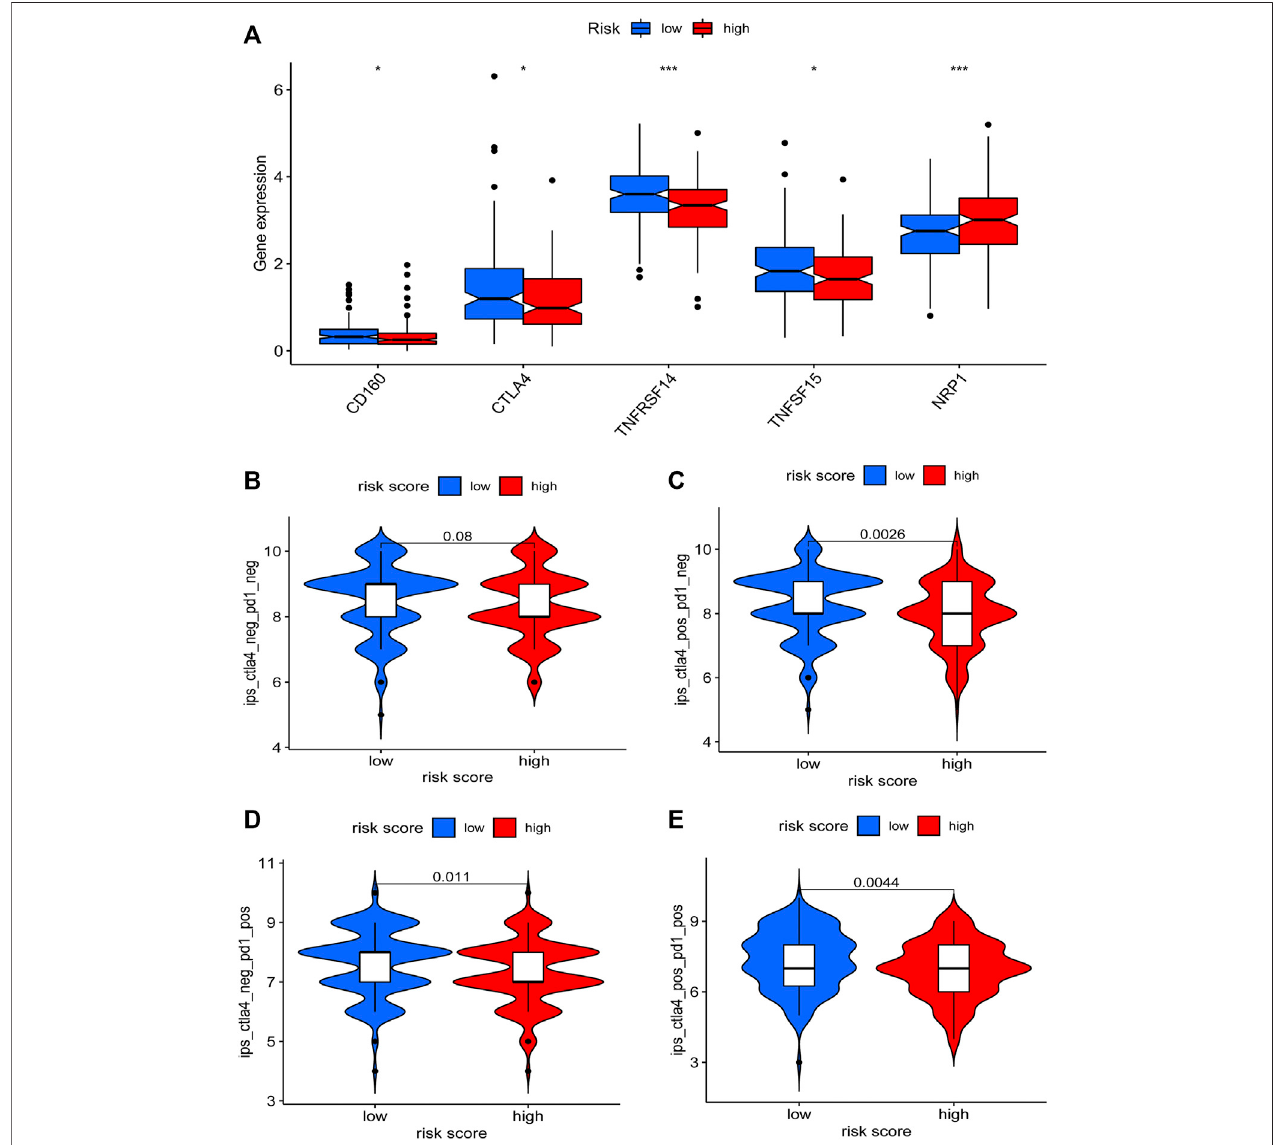
FIGURE8| Relationshipbetweenthe riskmodel and immunotherapy. Expression differencesofimmune checkpoint genesbetweenthe low-risk and thehigh-risk patients were determined (A) . The immunotherapy scores difference of GC patients with different status of CTLA4 or PD-1 between two groups were visualized (B – E) .